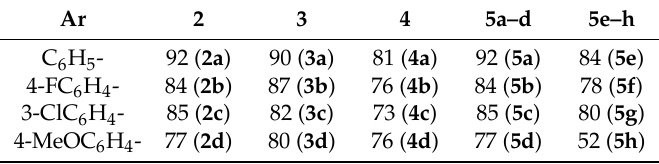
Table 1. Percentage yields of the compounds 5a – h and the corresponding reaction intermediates 2 – 4 .